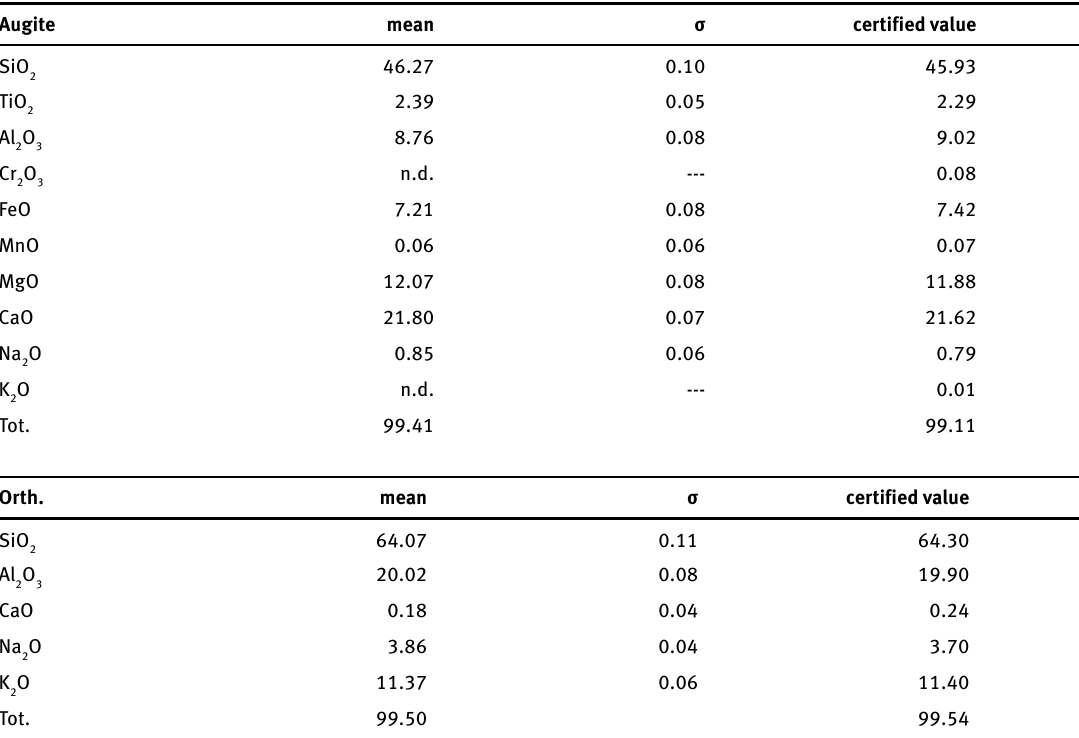
Table 3: Mean of 10 microanalyses on two reference standards (Augite and Orthoclase) with the relative standard deviation